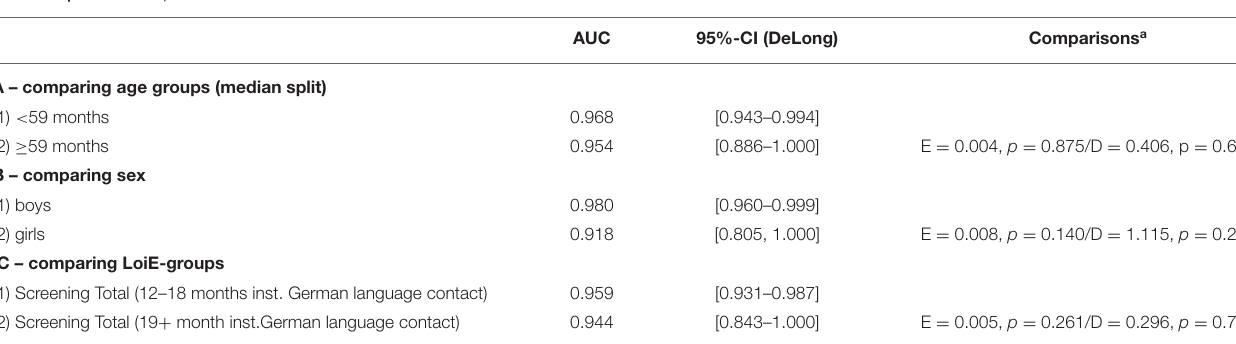
TABLE 4 | Tests for unpaired ROC